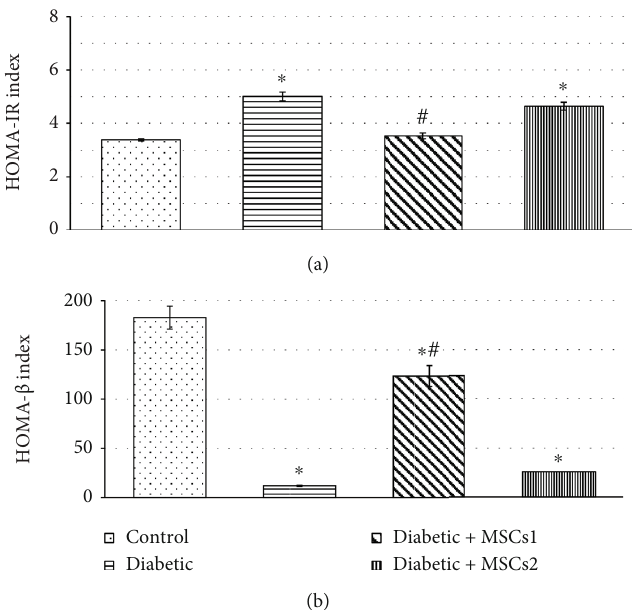
Figure 3: (a) Homeostatic model assessment of insulin resistance (HOMA-IR) and (b) homeostatic model assessment of pancreatic β cell function (HOMA- β ) of the control and experimental groups of developing diabetic rats. Values are expressed as mean ± SEM ( n = 6 ). Comparisons are ∗ p ≤ 0 : 05 signi fi cantly di ff erent from the control group and # p ≤ 0 : 05 signi fi cantly di ff erent from the diabetic